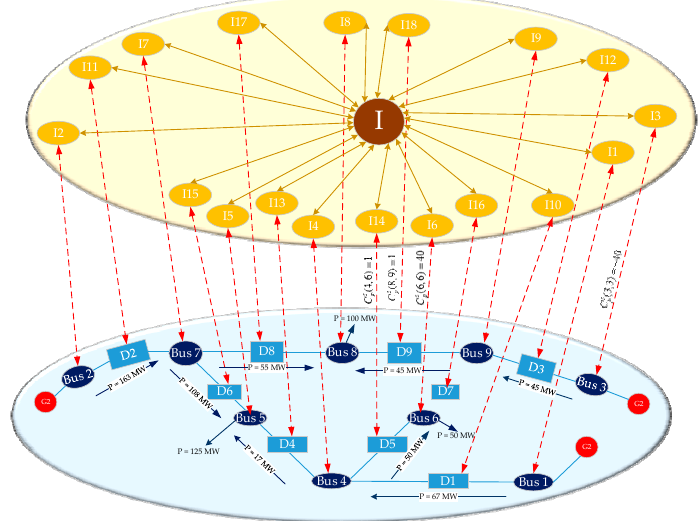
Table 1. The power flow transferring under power branch fault (MW).